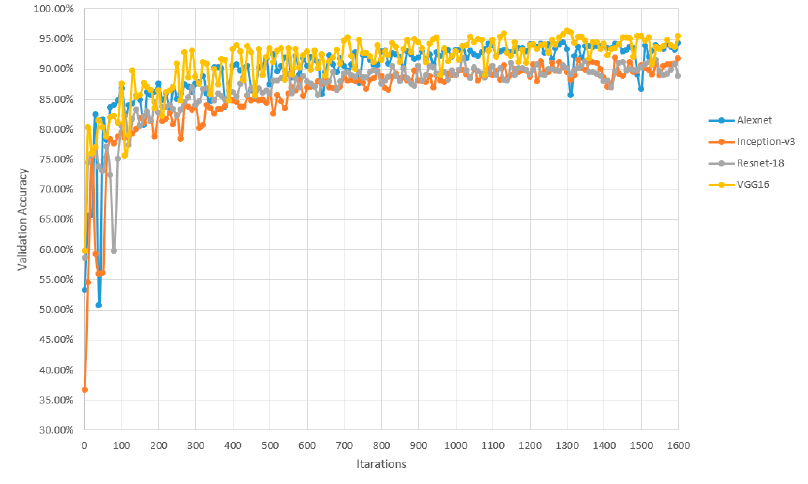
Figure 8. Validation accuracy rate iteration change graph.